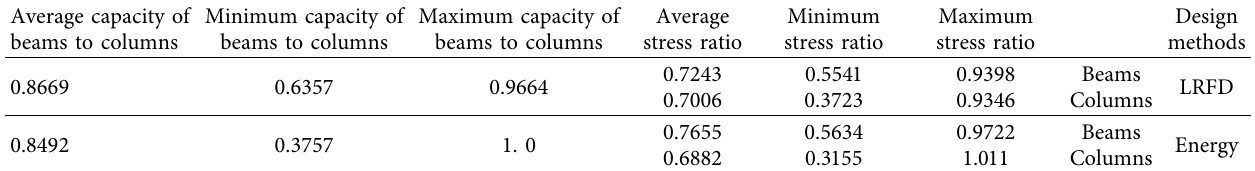
Table 6: Results of the analyses of LRDF, energy, and E-WOA methods in 8-story structures. Average capacity of